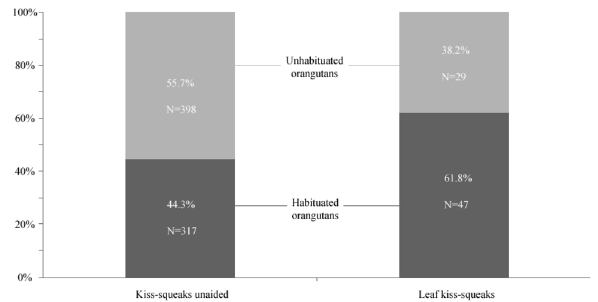
Figure 2. Percentage emitted by habituated and unhabituated individuals at Cabang Panti for unaided kiss- squeaks and leaf kiss-squeaks. doi: 10.1371/journal.pone.0069749.g002 between the size of the source structure (i.e. lips) and the signal’s acoustic signature, similar to calls produced at the vocal folds and tract [29].